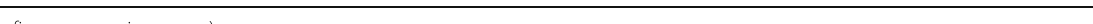
(See figure on previous page.) Fig. 3 Temporal variations in 15-day ACFs at station S21. a 15-day ACFs calculated from OBS data over 15 continuous days, including the 7 days before and after the given date. The ACFs plotted in red are in the SSE period, and the bottom ACF is the reference ACF, calculated for the month from November 19 to December 19. b The cross-correlation coefficient between the 15-day ACFs and the reference ACF, using a 15-s time window and zero lag time. The period between the black triangles corresponds to the SSE period, and the periods between the red, blue, and green triangles correspond to low-frequency tremor periods in sequences 1, 2, and 3. The magenta broken line represents the main shock. c Phase variation in the 15-day ACFs relative to the reference ACF, using a 15-s time window. Warm colors represent phase progressions, and cold colors represent phase delays. The four pairs of triangles and the magenta broken line correspond to each period and the main shock described in ( b